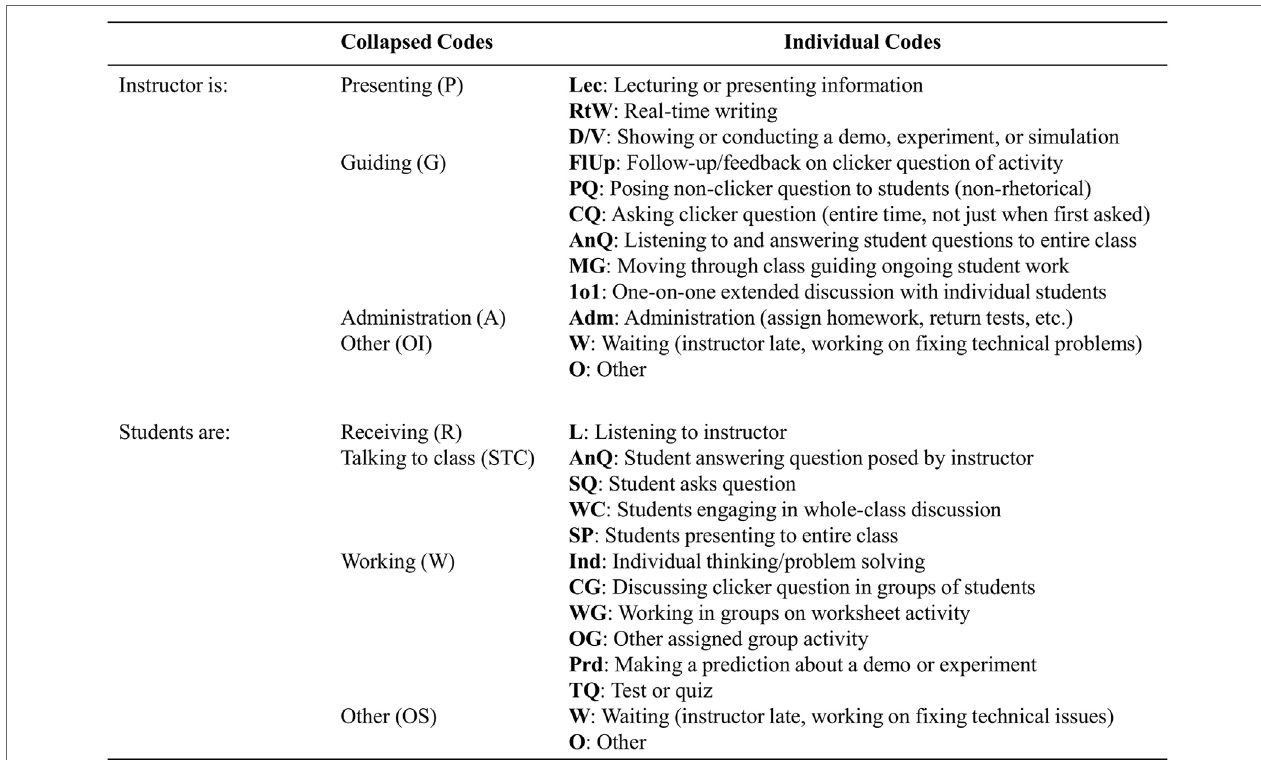
FigUre 1 | Classroom Observation Protocol for Undergraduate STEM instrument codes and abbreviated descriptions used to describe instructor and student behavior during in-class observations. The individual codes are further grouped into collapsed codes.